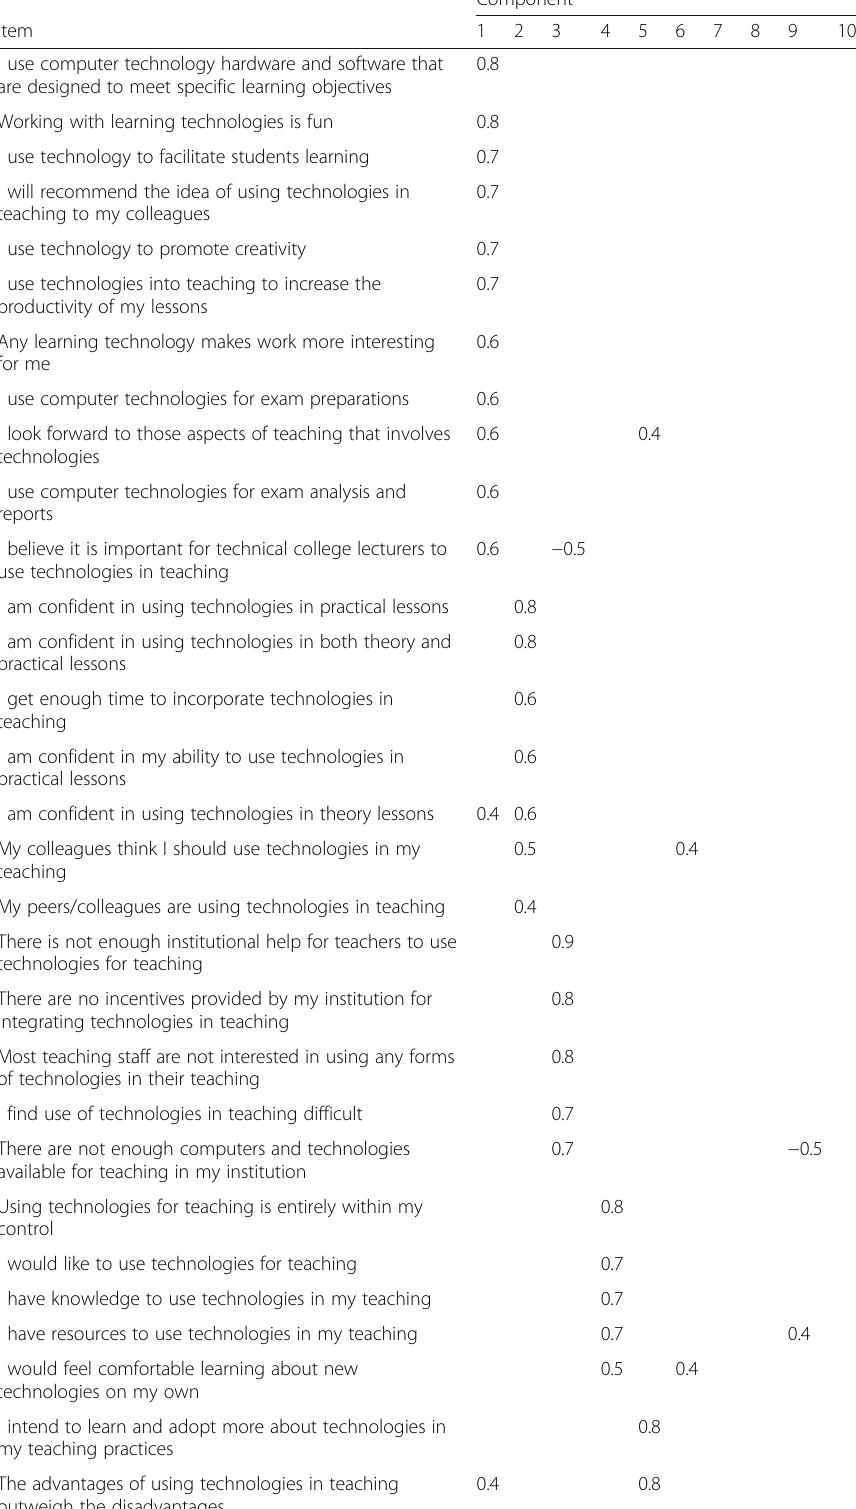
Table 1 Rotated Component